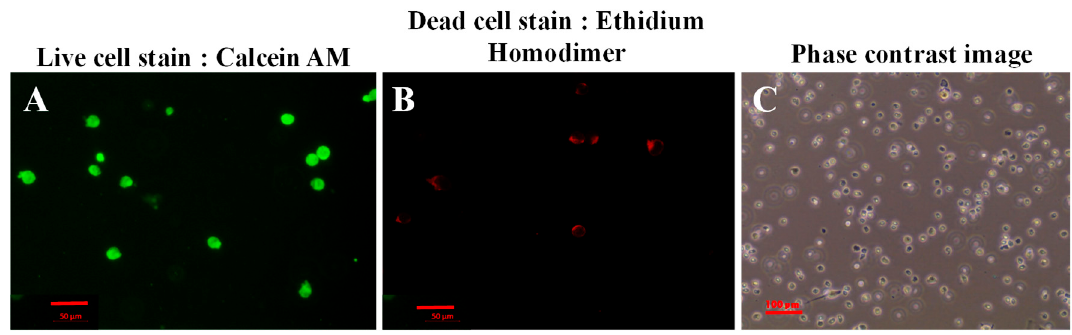
Figure 6. Live/Dead assay performed 15 min after printing and crosslinking. Shown in ( A ) are calcein stained live cells and in ( B ) are ethidium homodimer stained dead cells, respectively. In ( C ), a phase- contrast image of cells cultured for this experiment is shown.